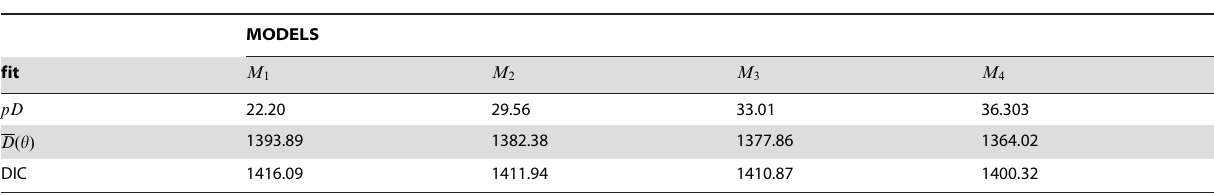
Table 3. Models comparison.